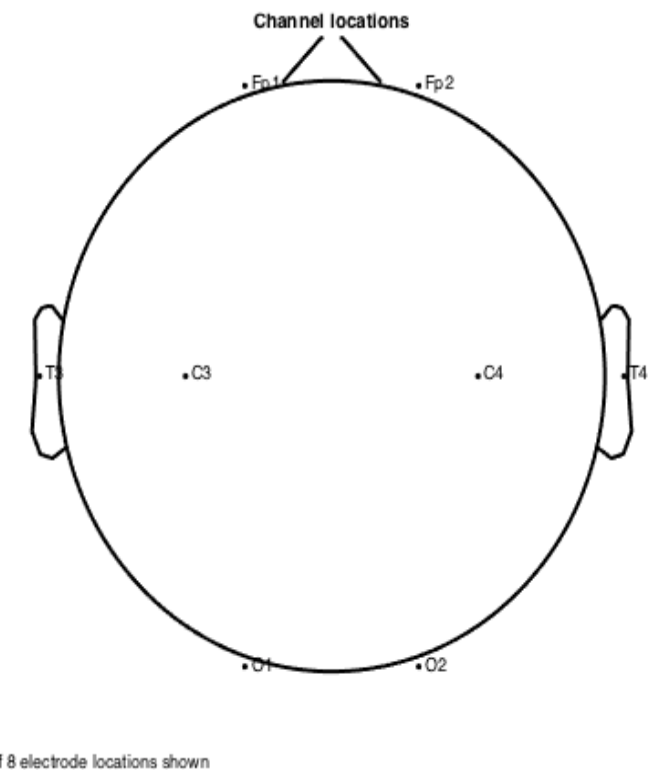
Figure A1. Schematic of electrode locations. All recordings were performed using an eight-electrode montage, with bilateral temporal (Fp1 and Fp2), temporal (T3 and T4), parietal (C3 and C4) and occipital (O1 and O2) electrodes, positioned per the 10–20 system. All recordings were carried out under resting state conditions. To minimise behavioural disturbance, patients were allowed to spend time adjusting to the recording environment and recordings were carried out for extended sessions, with the first several minutes discarded.